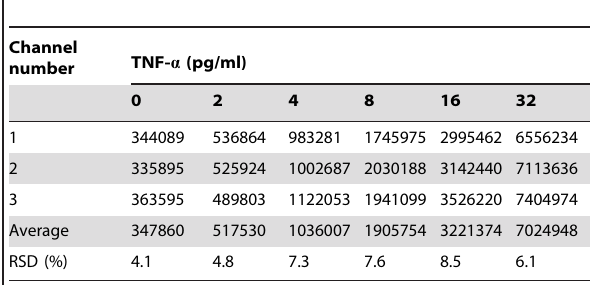
Table 4. Reproducibility of luminescence intensity of TNF- a in 3 different